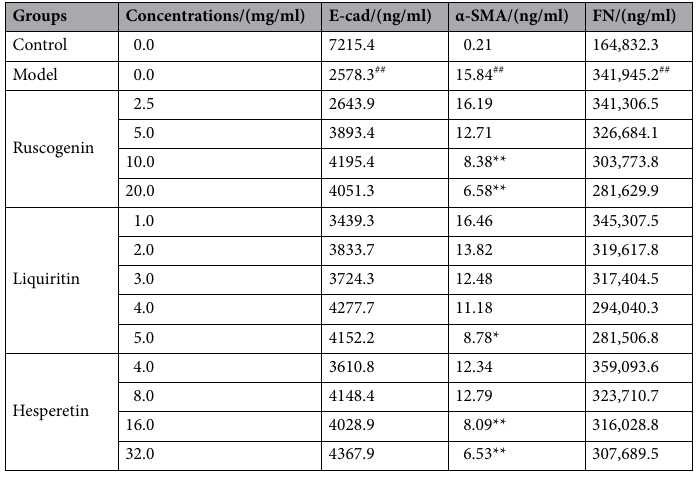
Table 5. The effect of ruscogenin, liquiritin, hesperetin on A549 cells (values represented as mean ± SD. ## P < 0.01 versus control group. **P < 0.01, *P < 0.05, versus model